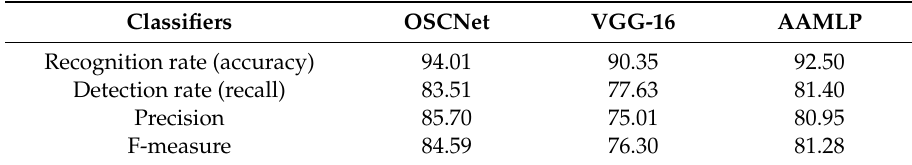
Table 9. Performance comparison of different classifiers.